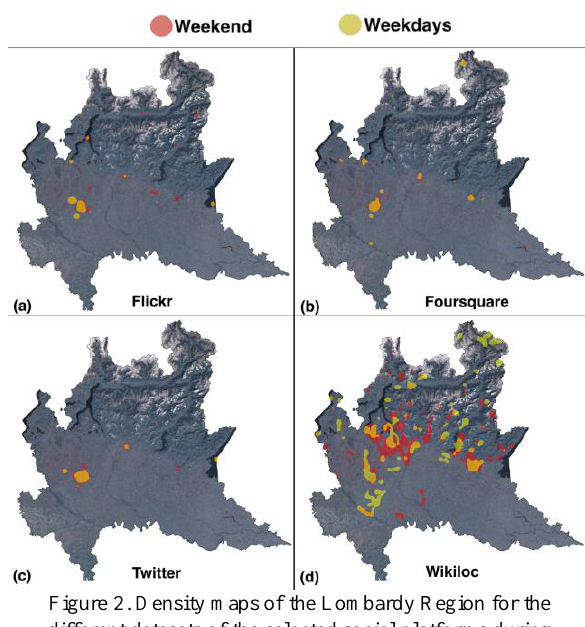
Figure 2. Density maps of the Lombardy Region for the different datasets of the selected social platforms during weekdays and weekends. (© 2016 MapQuest).